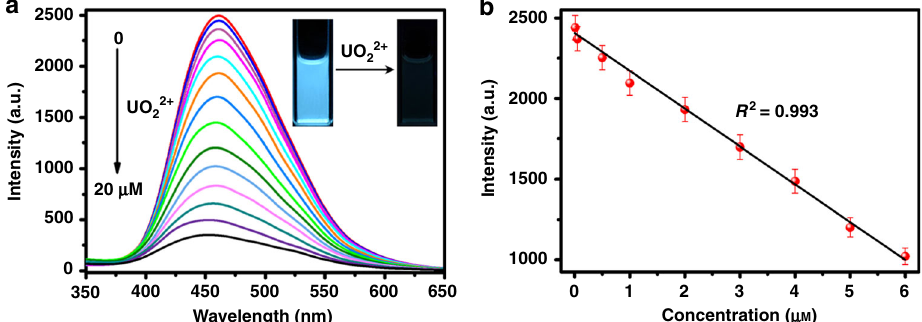
Fig. 4 Sensitivity investigations. a Fluorescence emission spectra of TFPT-BTAN-AO upon gradual addition of UO 2 2 + ( λ ex = 277 nm). Inset photos show the fl uorescence emission change (under a 365 nm UV lamp) of TFPT-BTAN-AO after addition of UO 2 2 + . b Fluorescence intensity at 460 nm versus the concentration of UO 2 2 + . Inset: The linear calibration plot for UO 2 2 + detection. Error bars represent S.D. n = 3 independent